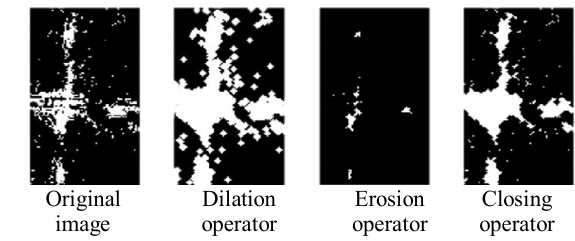
Figure 4. effects of morphological operators on binary